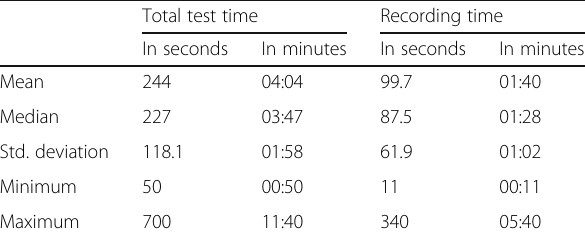
Table 5 Total test and recording time for SPD-CAT in seconds and minutes